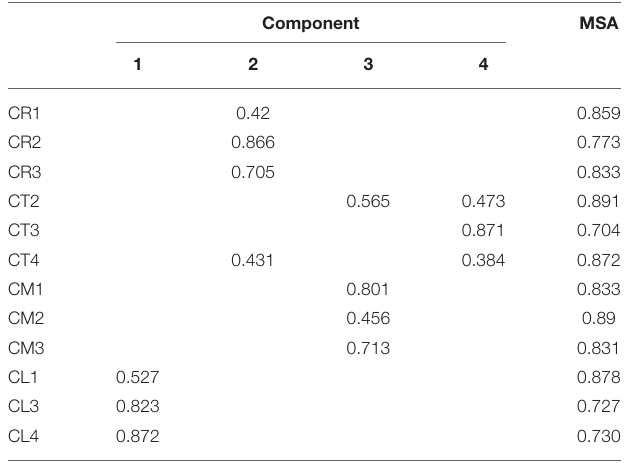
TABLE 5 | PCA on Characters dimension items (6) for the CCI-21 36 items version.